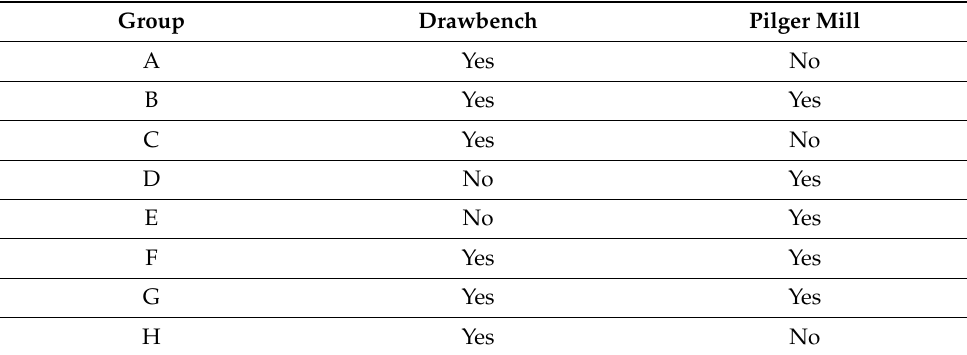
Table 4. Routing regarding drawbench and pilger